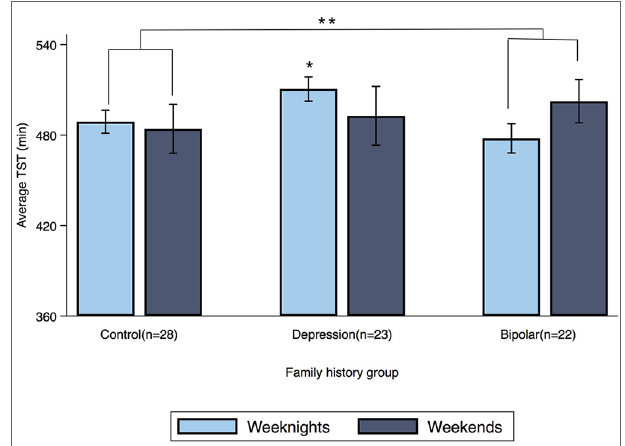
FIGURE 2 | Average TST for weeknights and weekends by family history group. Error bars represent the standard error of the mean. Note: * p < 0.05, ** p <